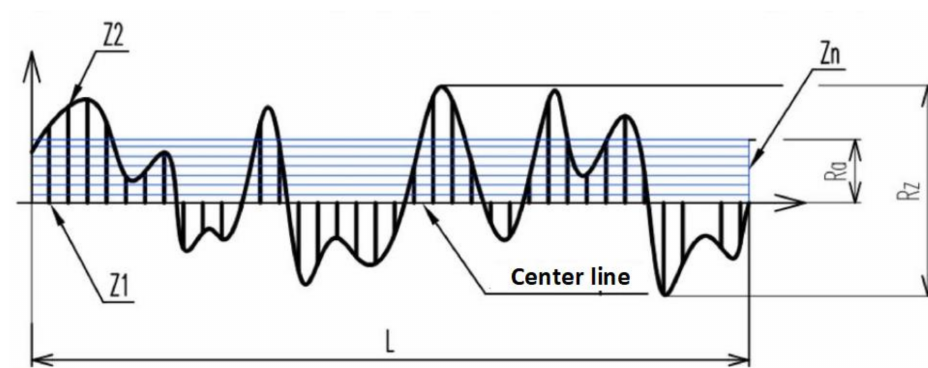
Figure A1. Average roughness Ra.